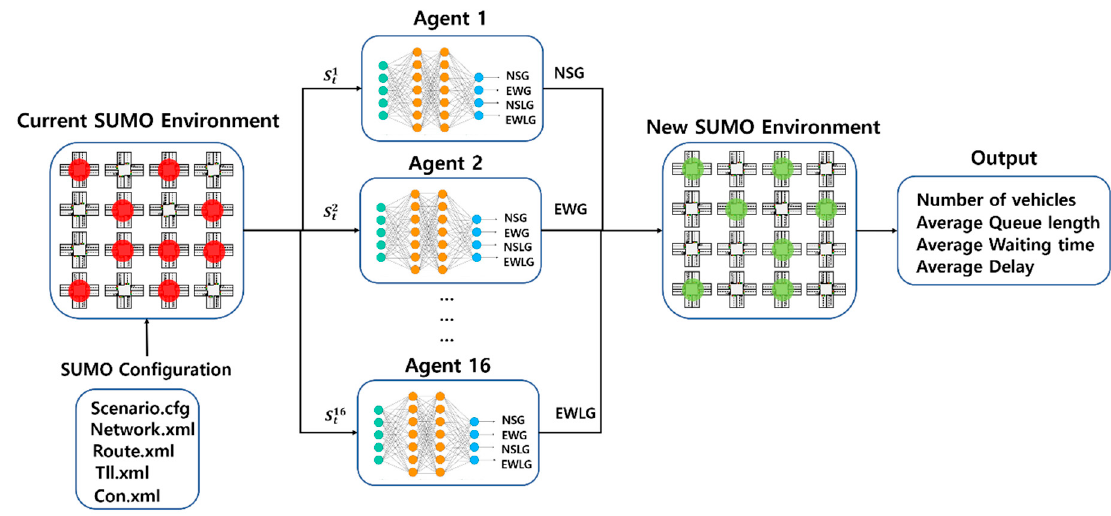
Figure 6. Experimental structure and procedure.